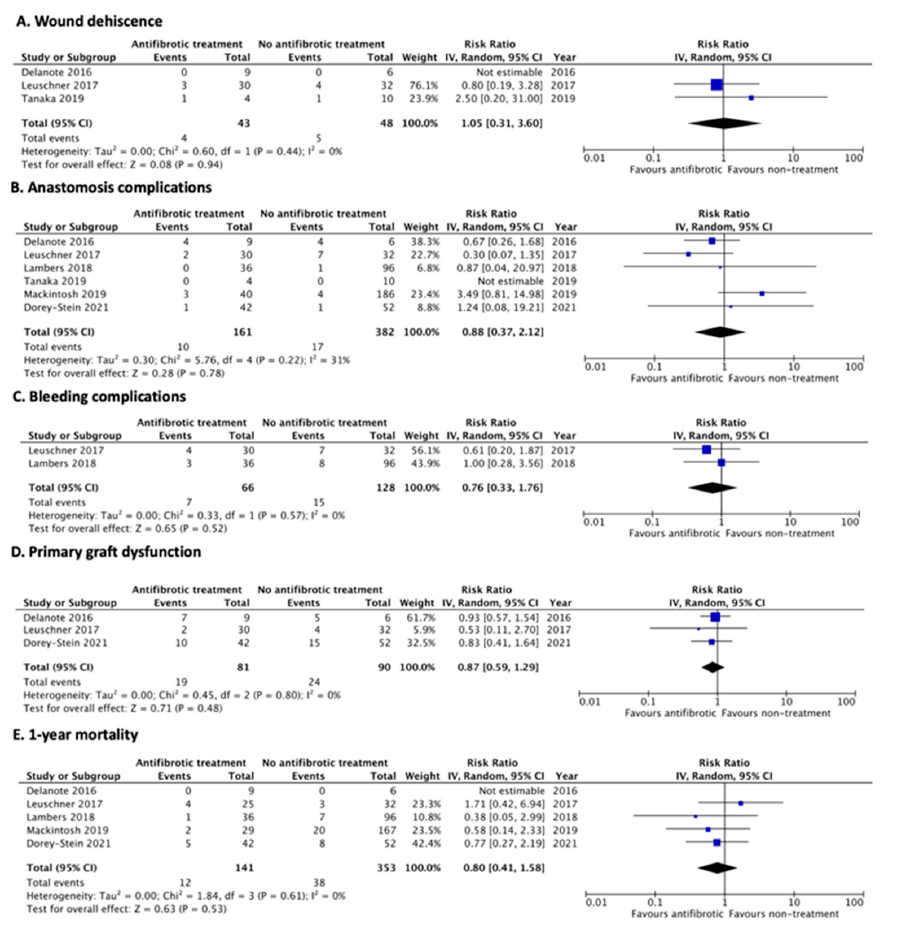
Figure 2. Forest plot of pooled risk ratio for all antifibrotic treatments [12,21–25]. ( A ) surgical wound dehiscence, ( B ) anastomosis complications, ( C ) bleeding complications, ( D ) primary graft dysfunction at 72 h after transplantation, and ( E ) 1-year mortality after LT.